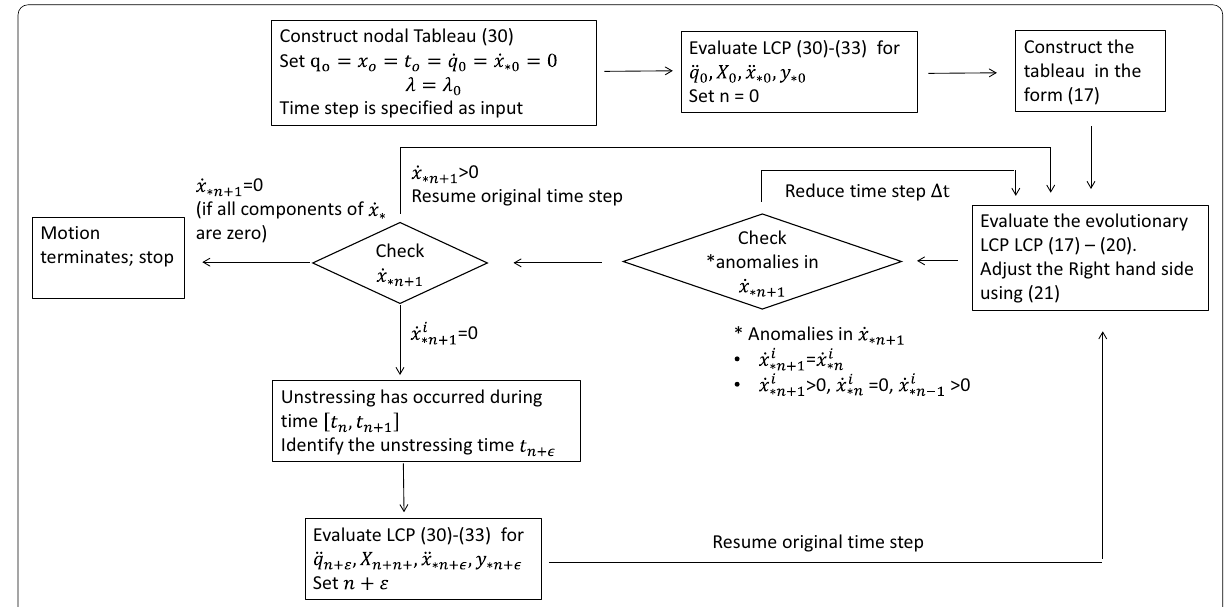
Fig. 5 Iterative procedure of LCP response.